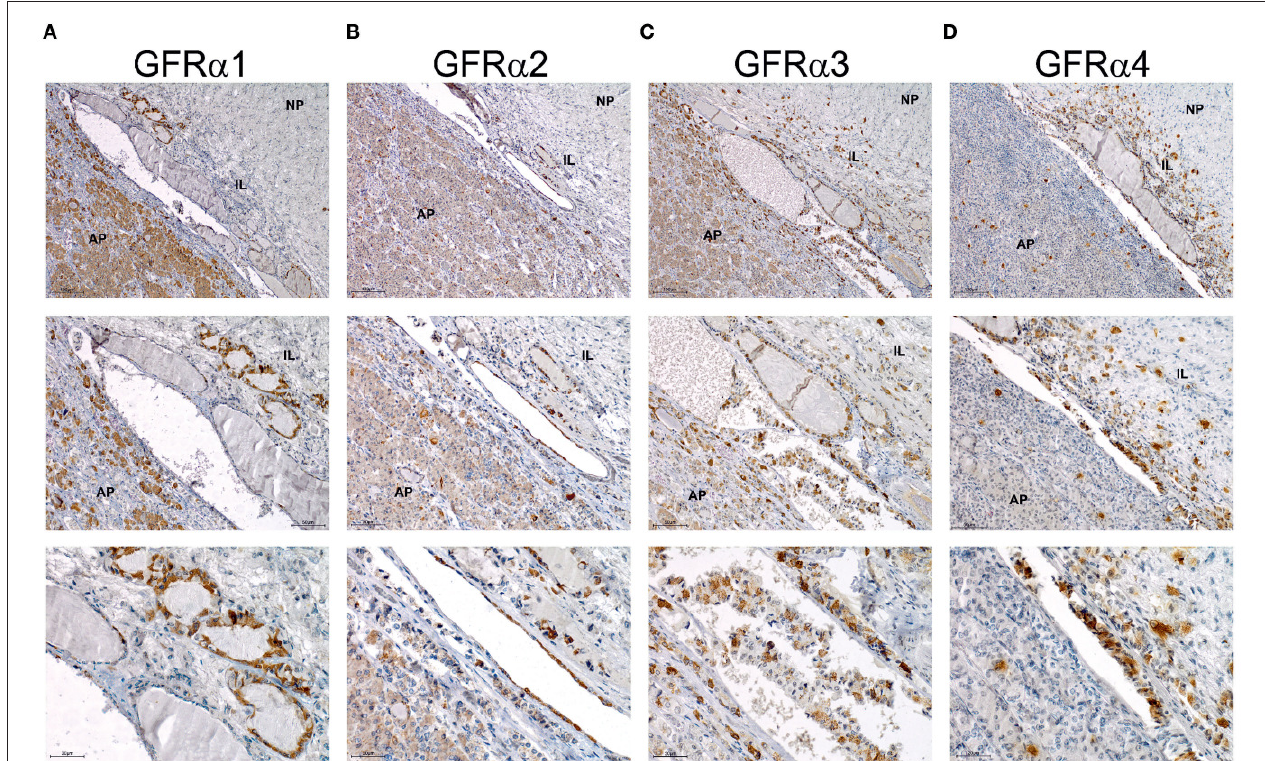
FIGURE 6 | Expression of the GFR α 1-2-3 and 4 co-receptors in human pituitary. Immunohistochemistry of each co-receptor in sagittal sections of human pituitary counterstained with Haematoxylin to reveal nuclei. Three magnifications are shown per field. Top row pictures show a global vision of pituitary and general distribution of the four GFR α co-receptors. Middle row has a higher magnification in order to focus specially in intermediate lobe and adenopituitary. Bottom row shows a close-up view of the stem cell niche composed of RC. (A) GFR α 1 is abundantly expressed at the AP but intensity at the niche is higher. At highest magnification intensely stained RCs are shown. (B) GFR α 2 is highly expressed at the niche with some isolated cells through the AP. At highest magnification intensely stained RCs are shown. (C) GFR α 3 is highly expressed at the niche. Few isolated cells are present at the AP but also at the IL. At highest magnification intensely stained RCs are shown. (D) GFR α 4 presents a similar staining with high intensity at the niche, and isolated cells in the AP and IL. At highest magnification intensely stained RCs are shown. AP, Adenopituitary; IL, Intermediate Lobe; NP,